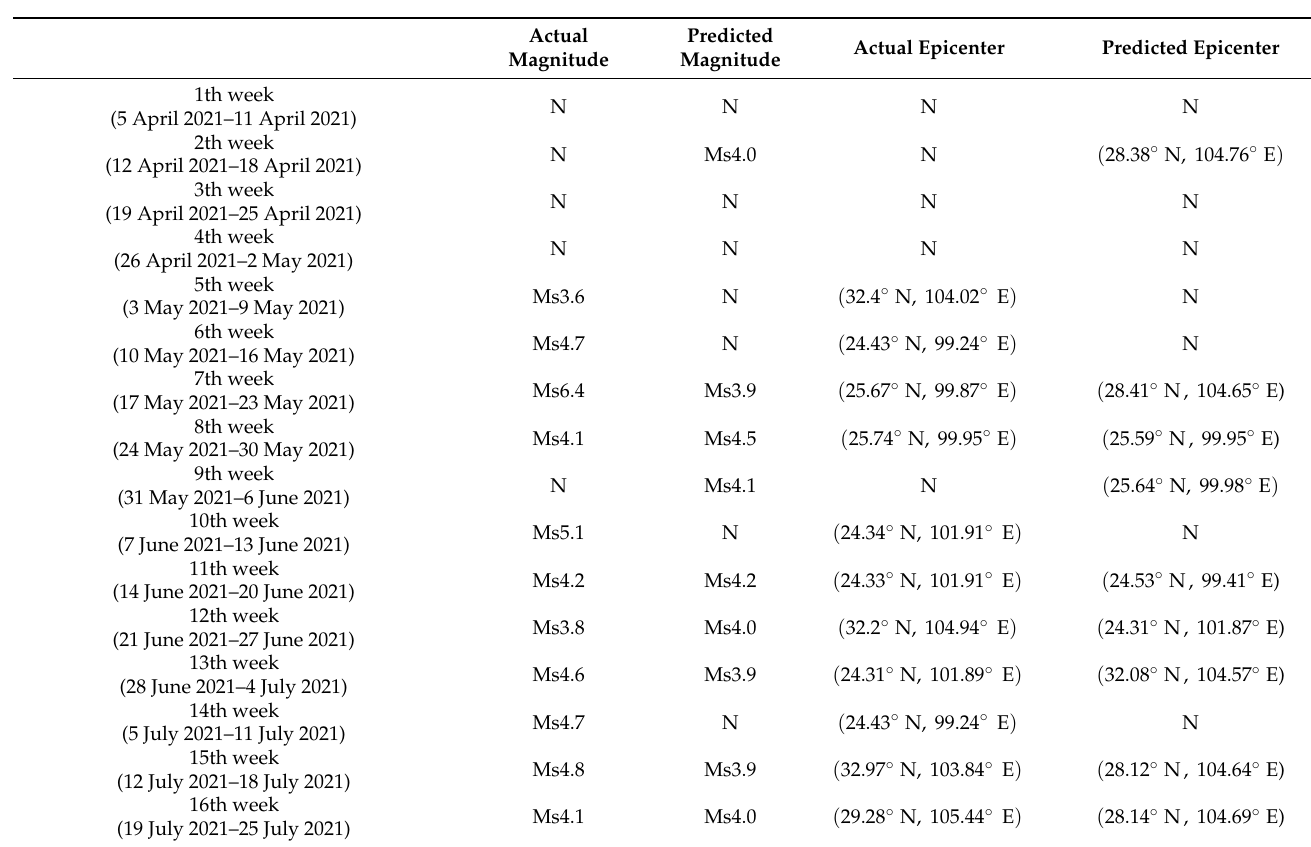
Table 3. The results of real-earthquake prediction. Actual Predicted Actual Epicenter Predicted Magnitude Magnitude